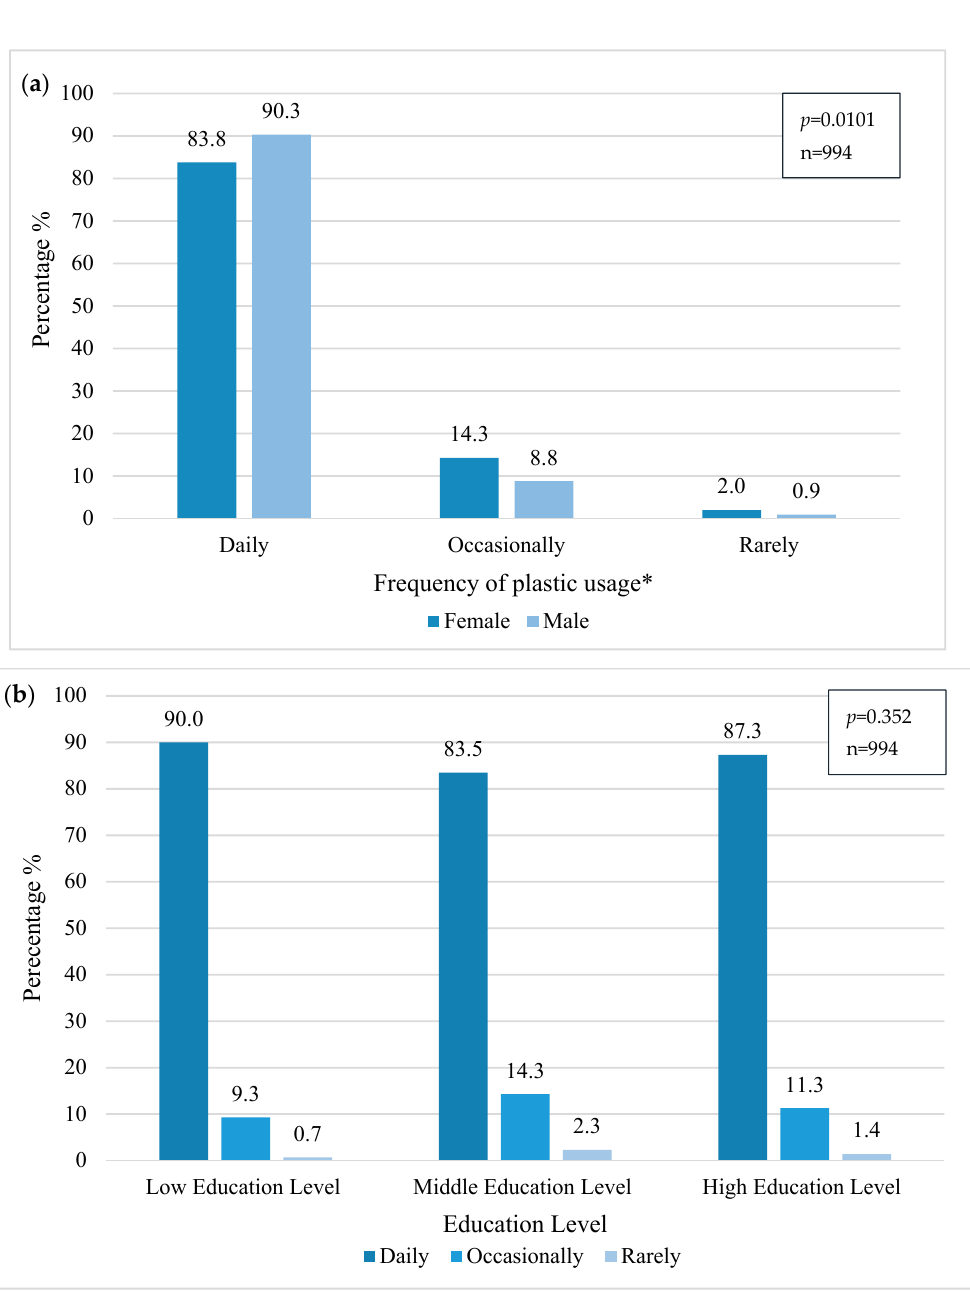
Figure 3. Frequency of plastic usage within the sample. ( a ) * Significant relation (chi2, p = 0.010) between gender and frequency of plastic usage. ( b ) No significant relation (chi2, p = 0.352) between education levels and frequency of plastic usage.